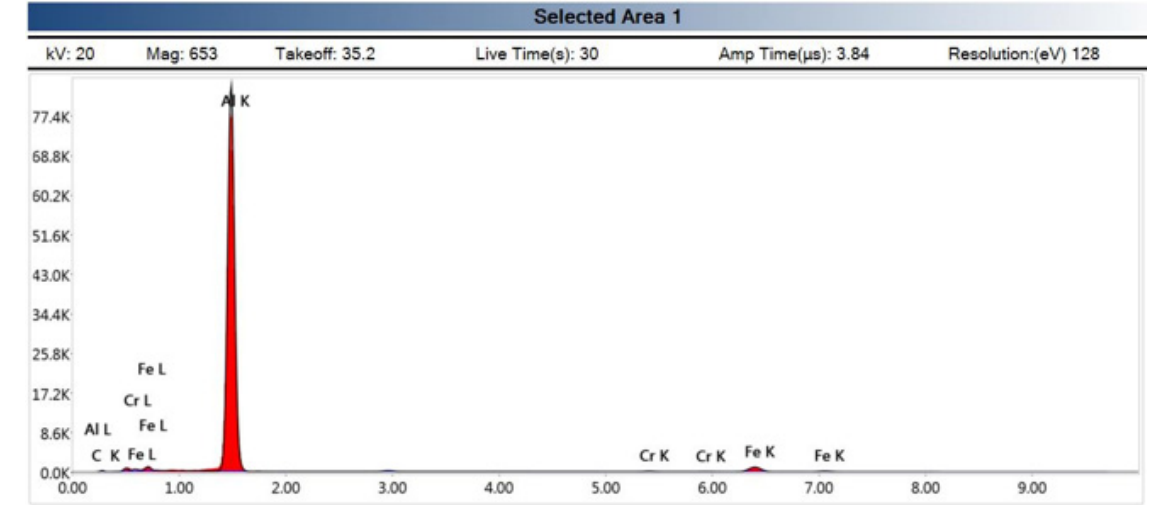
Figure 9. EDX of the Al6061 after 15 min of stirring.